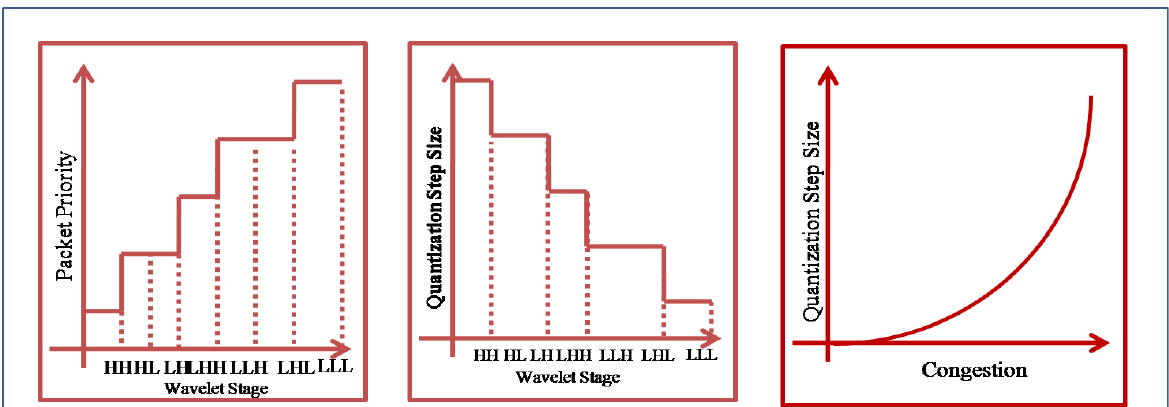
Figure 12. Priority and